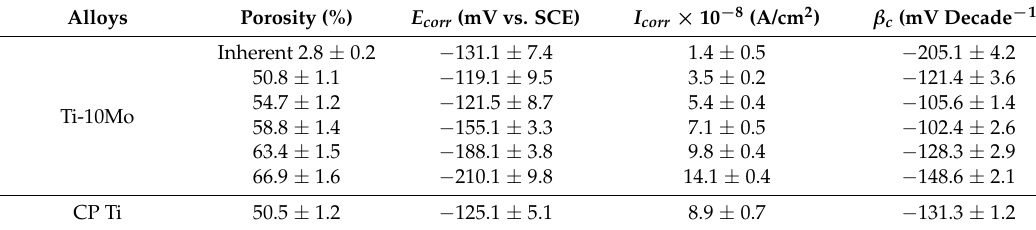
Table 3. Corrosion parameters of Ti-10Mo with different porosity in naturally aerated phosphate-buffered saline solution at 37 °C obtained by Tafel analysis.